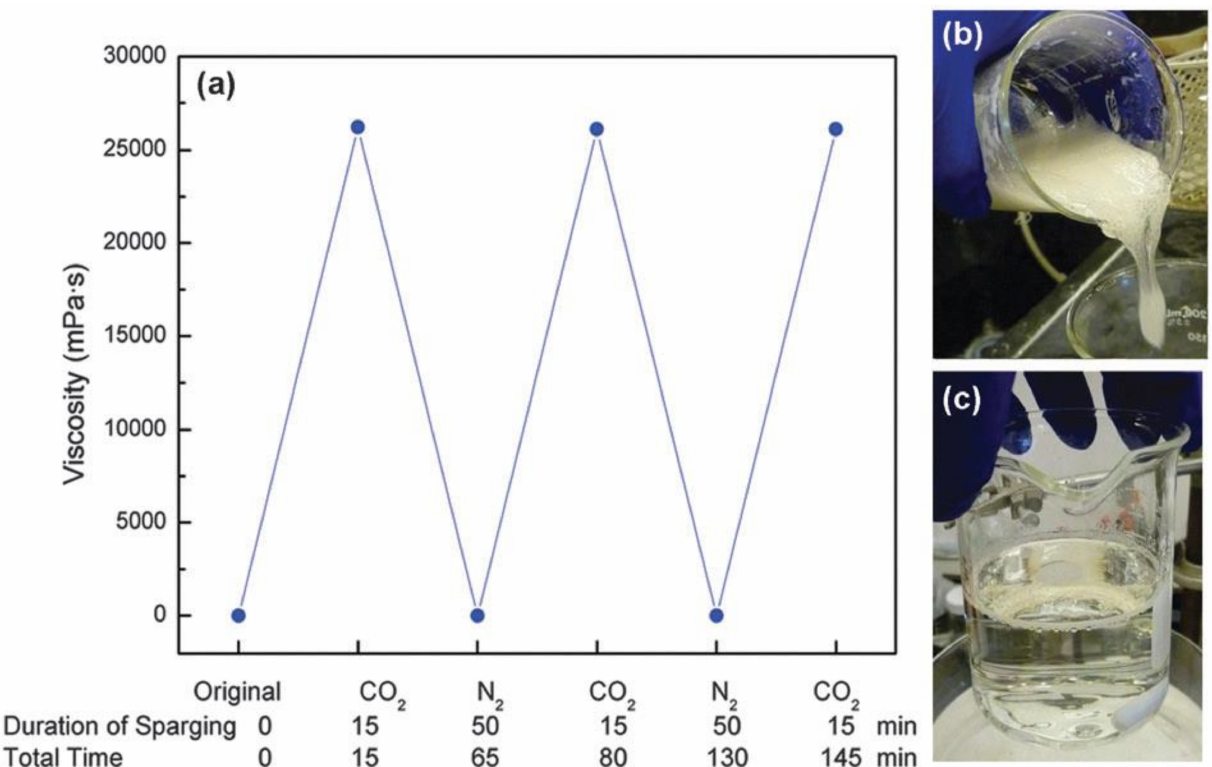
Figure 11. The aqueous solution of C18SNa (200 mM) and DMAE (200 mM) was transitioned from low and high zero-shear viscosity phases by switching CO 2 (1 bar) and N 2 (1 bar) treatments for three series at 60 ◦ C ( a ); The water solution was produced by mixing 100 mL distilled water with C 18 SNa and manually agitating it at 60 ◦ C for several minutes. It was viscous, with a viscosity of 1.1 mPas. After adding the DMAE, the viscosity was 1.2 mPas. After 15 minutes of sparging CO 2 at 60 ◦ C, the solution formed a gel with a viscosity of 26200 mPa · s. ( b ); the viscosity was restored to its previous value of 1.2 mPa · s after sparging N 2 for 50 minutes at 60 ◦ C ( c ). “Reproduced with permission from Ref. [113]; 2022, Royal Society of